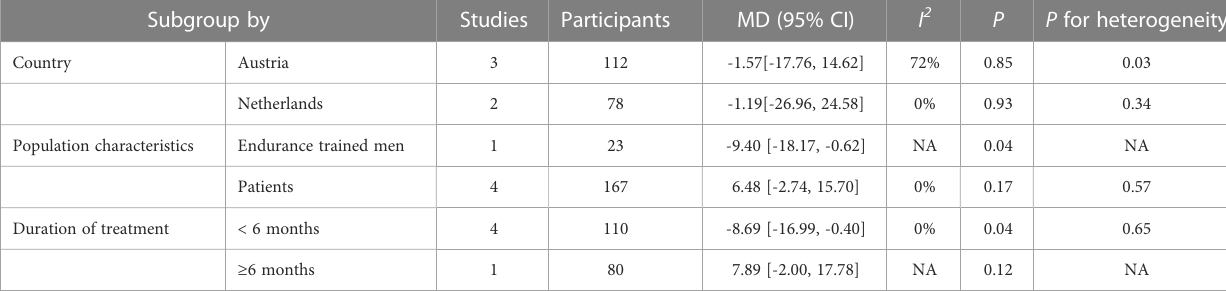
TABLE 4 Subgroup analysis of fecal zonulin.